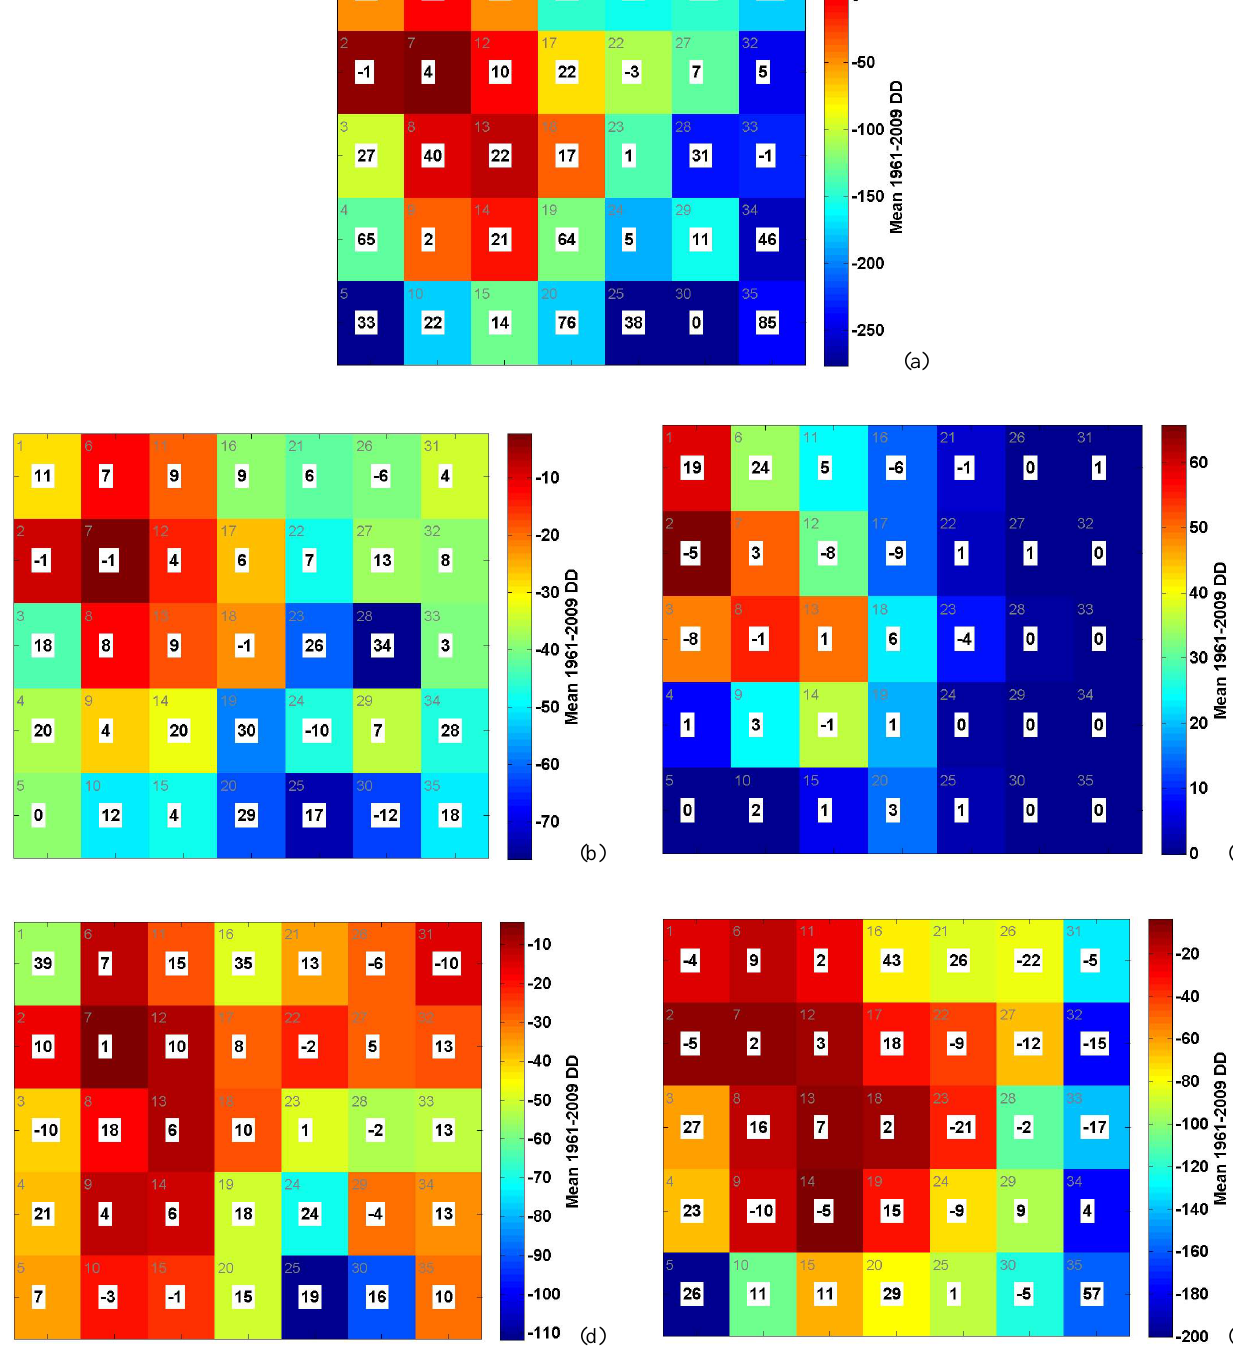
Fig. 9. (a) Annual, (b) MAM (spring), (c) JJA (summer), (d) SON (fall), and (e) DJF (winter) changes in degree-days between means